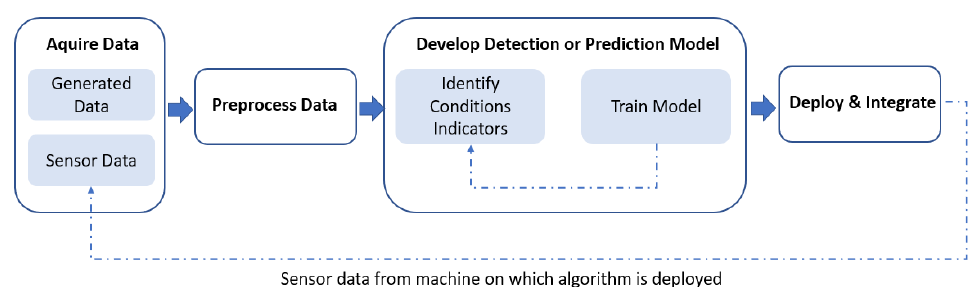
Figure 4. Prediction process .